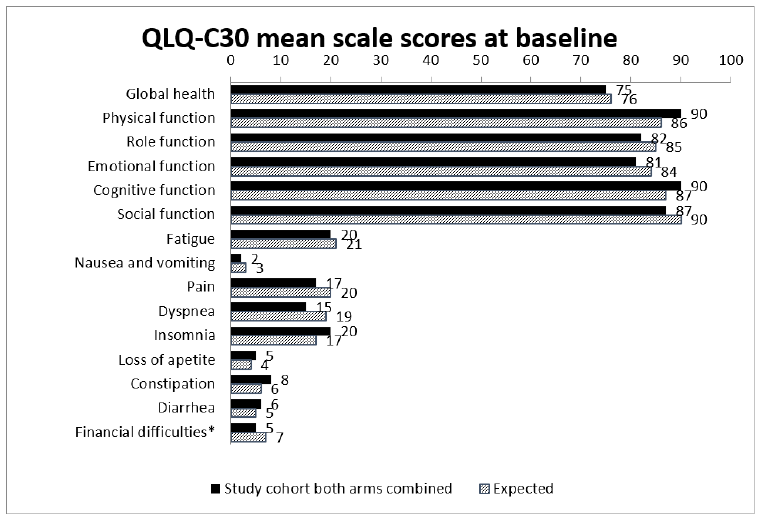
Figure 3. Observed and expected mean scale scores for both arms combined at baseline compared to general population (expected). Expected mean scale scores are calculated using indirect stand- ardization with normative scores from the general Swedish population. * Financial difficulties re- lated to disease. Levels of anxiety and especially depressive symptoms were generally low in the study group. At baseline assessments, 1.9 and 1.0% of study participants, respectively, were considered probable cases regarding depressive symptoms. Levels of anxiety at baseline were higher, with 6.1% probable cases in the experimental arm and 2.9% probable cases in the standard arm. (Figure 4A,B).